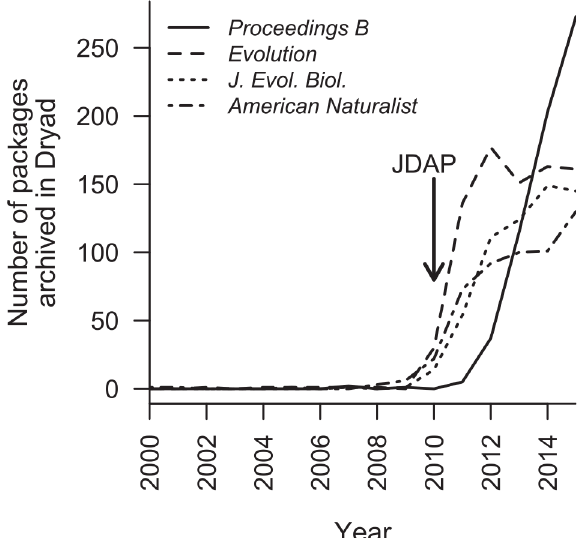
Fig 3. Total number of data packages archived in the Dryad Digital Repository each year for four leading journals within ecology and evolutionary biology. Arrow indicates when the Joint Data Archiving Policy (JDAP) was adopted by Evolution , Journal of Evolutionary Biology , and The American Naturalist . Note that because data packages are assigned a publication date by Dryad prior to journal publication (even if an embargo is imposed), some data packages will have been published in the year preceding the journal publication of their associated article.